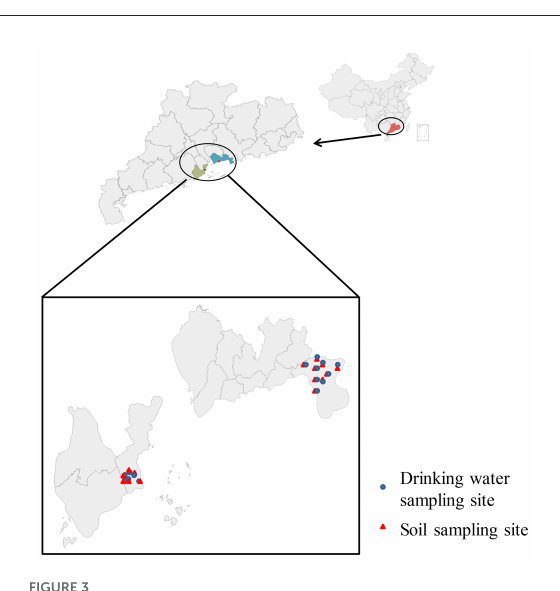
FIGURE3 Pearson correlation coefficients between heavy metals (Pb and Cd) and obesity indices (BMI, WC, and WHR).